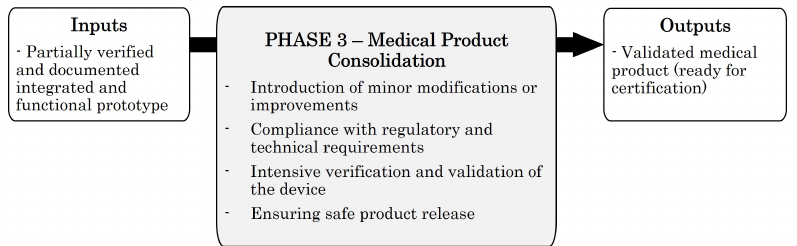
Figure 14. Medical Product Consolidation phase: key characteristics, inputs and